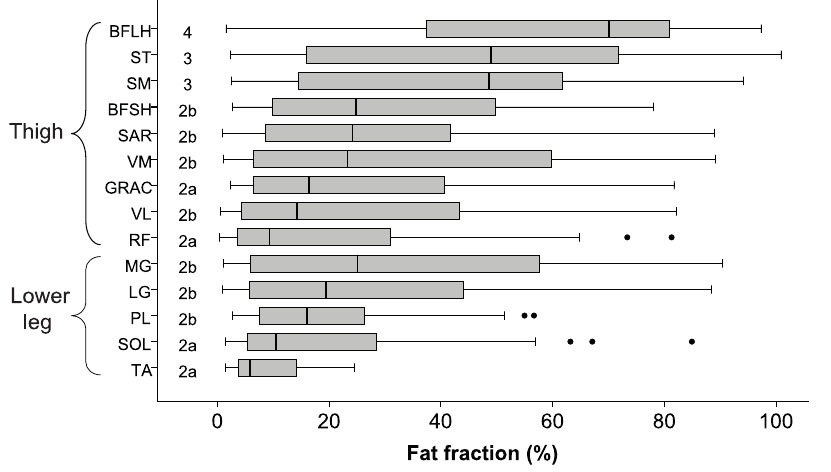
Figure 3. The grey bars illustrate the quantitative fat fractions for LGMD2I patients with median qualitative score at the left of the bars. The grey box indicates the lower and upper quartiles, with the median represented as a bar within the grey box and the stems the range (the outliers more than 1.5 interquartile range are marked separately as dots). (BFLH= biceps femoris long head, ST= semitendinosus, SM= semimembranosus, BFSH= biceps femoris short head, SAR= sartorius, VM= vastus medialis, GRAC= gracilis, VL= vastus lateralis, RF= rectus femoris, MG= medial gastrocnemius, LG= lateral gastrocnemius, PL= peroneus longus, SOL= soleus, TA= tibialis anterior).